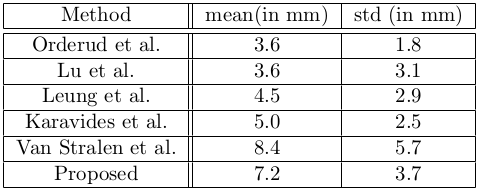
Table from the paper: Cardiac Motion Analysis by Temporal Flow Graphs
Table text:
Method
mean(inmm)
std(inmm)
Orderudetal.
3.6
1.8
Luetal.
3.6
3.1
Leungetal.
4.5
2.9
Karavidesetal.
5.0
2.5
VanStralenetal.
8.4
5.7
Proposed
7.2
3.7